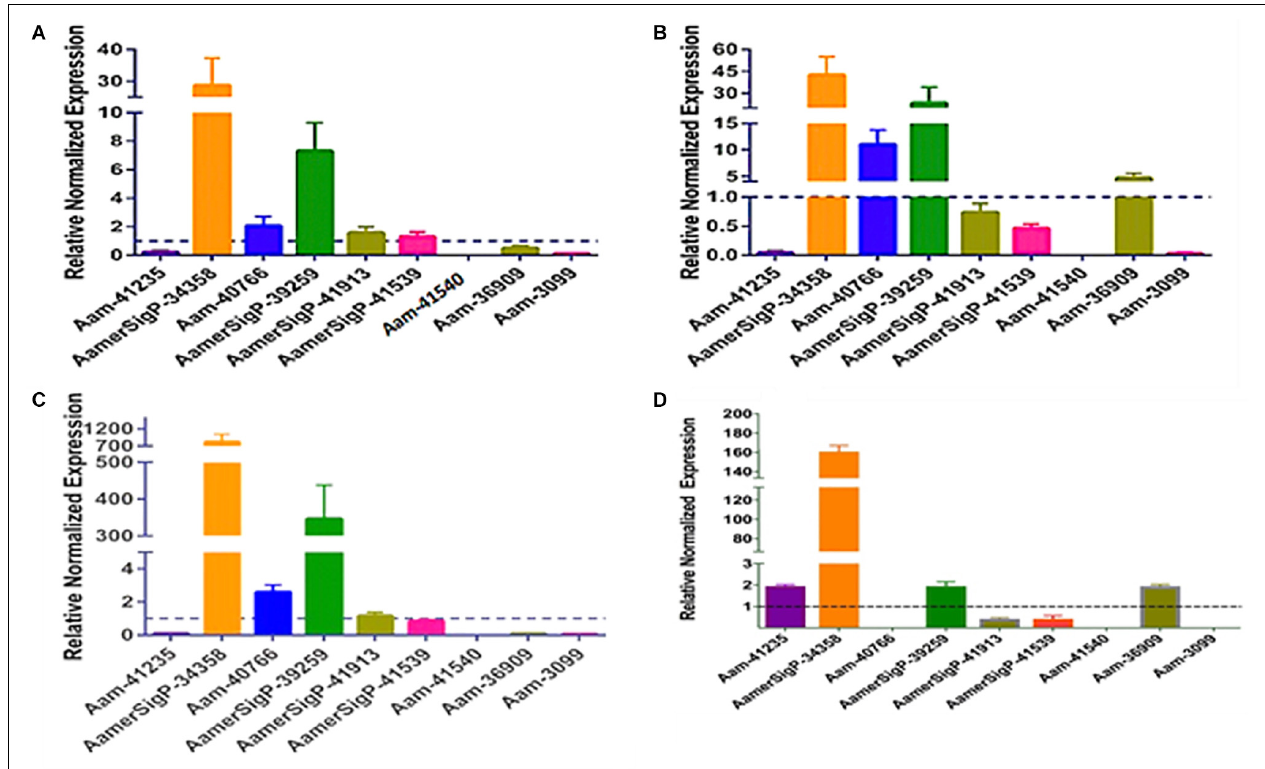
FIGURE 6 | Transcriptional expression of tick GRP genes in unfed ticks after stress exposure. Quantitative reverse transcriptase PCR (qRt-PCR) was used to determine the transcriptional expression levels of tick GRPs. (A) cold temperature, (B) hot/humid temperature, (C) injury, and (D) oxidative stress. The expression levels in tick control samples were set to 1, as represented by dashed lines. Ubiquitin was used as a housekeeping gene to normalize the transcriptional